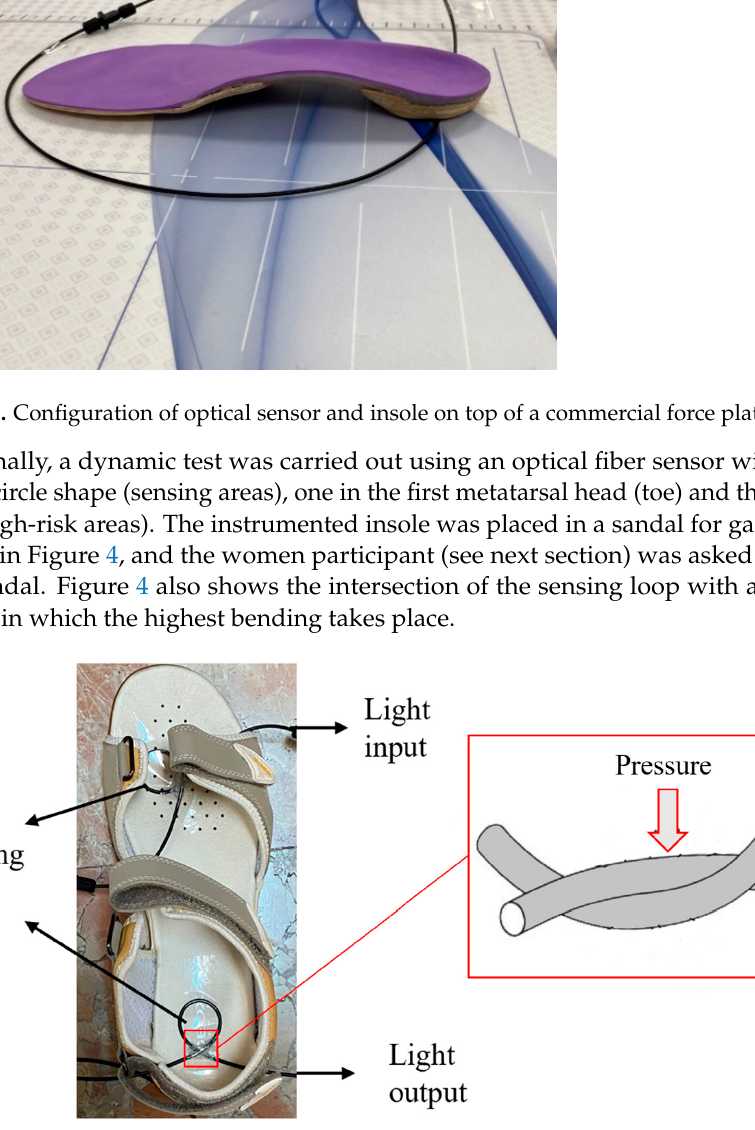
Figure 4. POF sensors positioned in a sandal for in-shoe measurements of plantar pressure with a zoom of intersection part of the fiber.